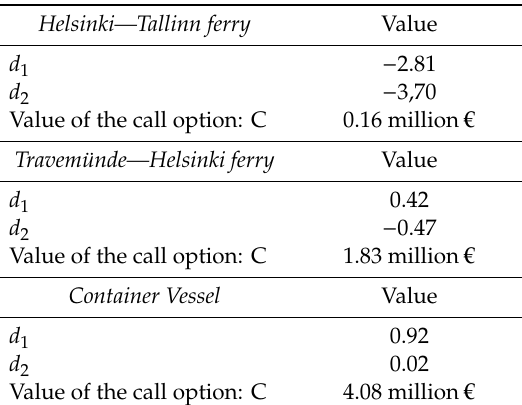
Table 7. ROA for a 20-year horizon value.